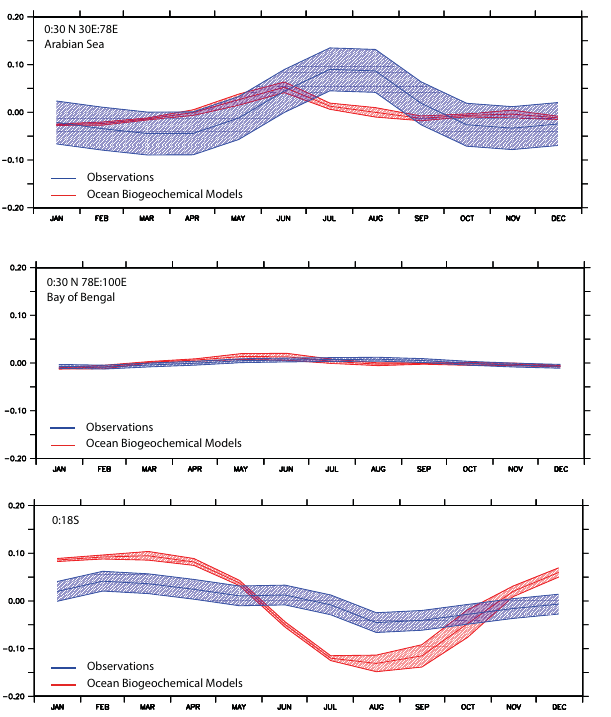
Fig. 8. Seasonal cycle CO 2 flux anomaly for parts of the north- ern Indian Ocean (PgCyr − 1 ) from observations and ocean biogeo- chemical models: the Arabian Sea (0–30 ◦ N, 30–78 ◦ E; upper), the Bay of Bengal (0–30 ◦ N, 78–100 ◦ E; middle) and the area between 0 and 18 ◦ S